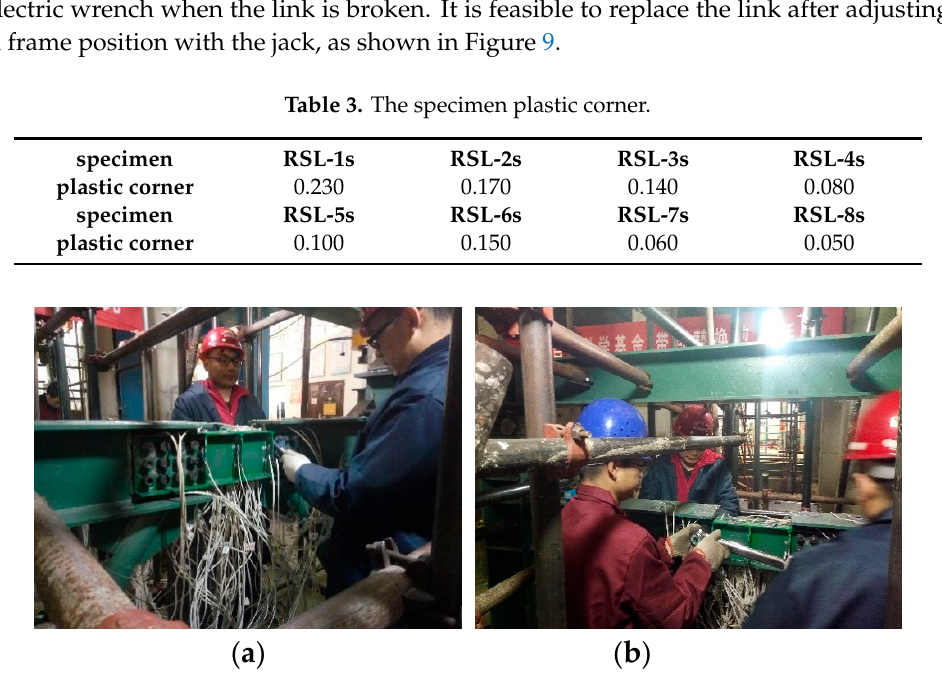
Figure 8. Failure modes of RSL-4. ( a ) flange bending; ( b ) vanished leather bulging; ( c ) flange bending; ( d ) flange bending.